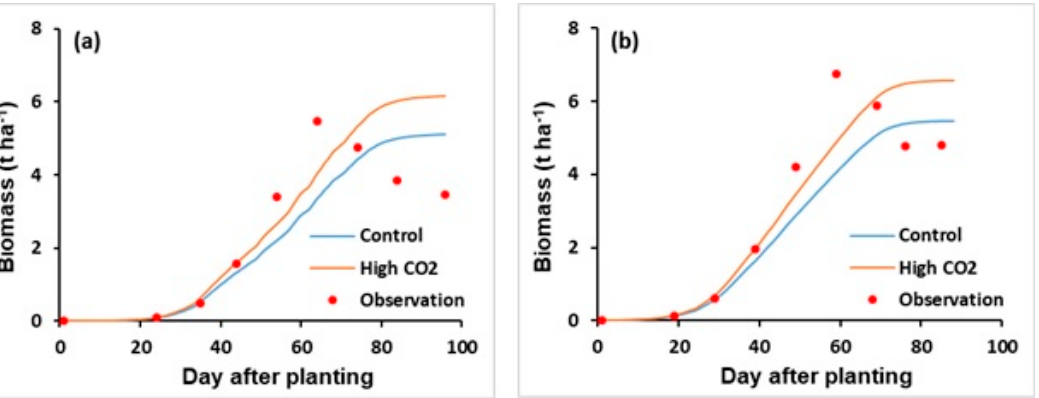
Figure 8. Total aboveground biomass under different atmospheric CO 2 concentrations for the control (350 ppm) and high CO 2 (600 ppm), and observed total biomass from the experiment site. ( a ) Summer-Autumn 2020; ( b ) Spring-Winter 2021. Relative yield changes were simulated with increasing temperatures and CO 2 concen- trations, as shown in Figure 9. The soybean yield rapidly decreased in the Summer–Autumn of 2020 with about a 7% reduction per ◦ C increase, while in the Spring–Winter of 2021, this reduction was about 2.3% (Figure 9a). With an increase in the CO 2 concentration,